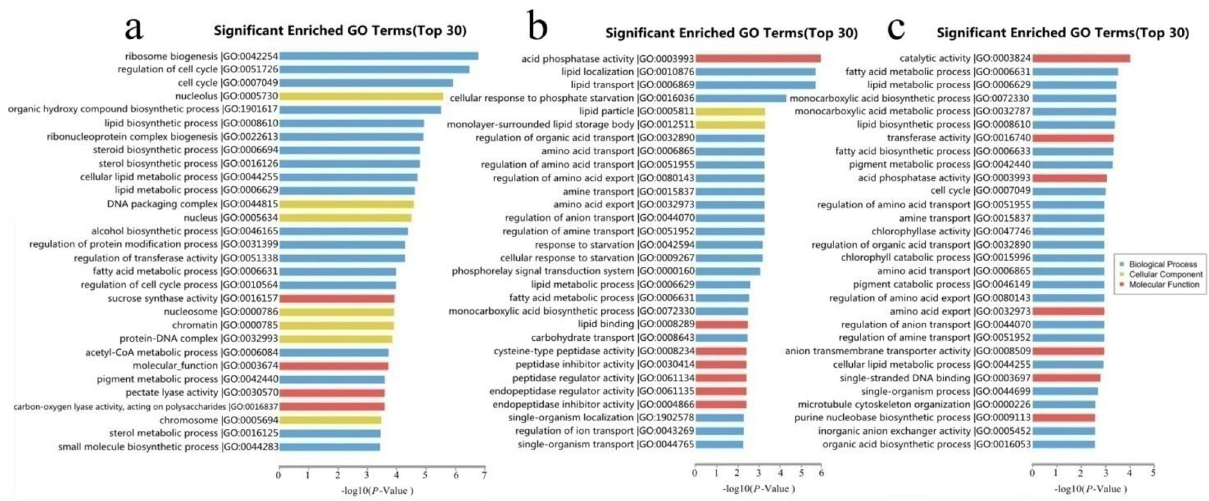
Fig 6. Gene ontology (GO) function enrichment analysis, GO terms of differentially expressed genes in rapeseed buds. a: 1258A_SB vs_1258A_MB top 30 GO terms. b: P5A_SB_vs_P5A_MB top 30 GO terms. c: P26R_SB_vs_P26R_MB top 30 GO terms. GO enrichment analysis of DE genes with a p - value < 0.05.